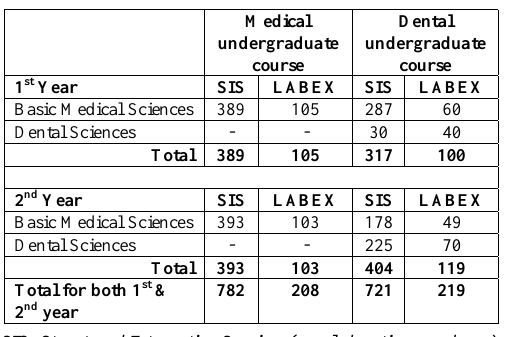
Table III : Curricular content of medical and